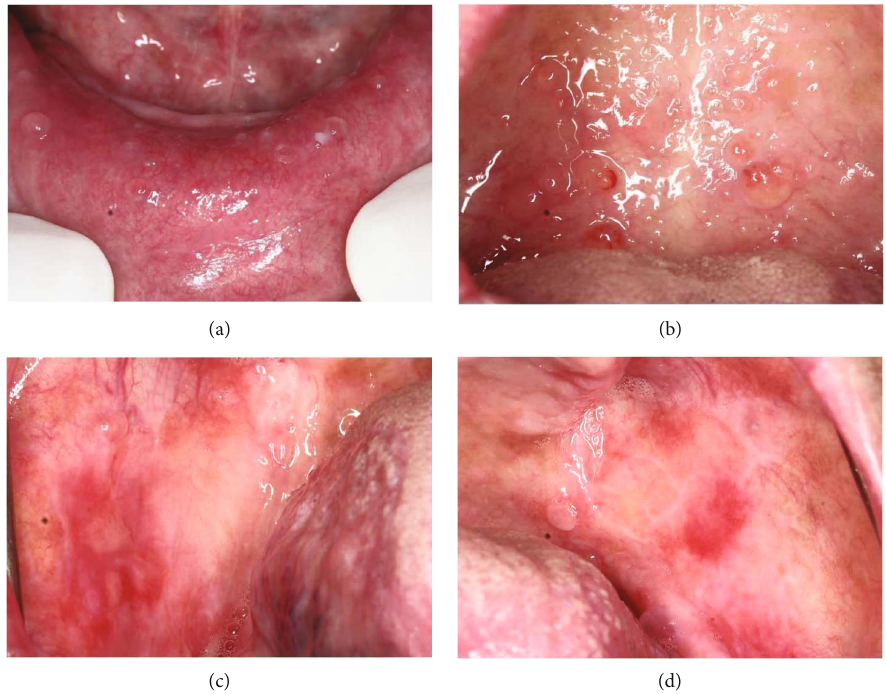
Figure 1: Multiple super fi cial mucoceles at the lower labial mucosa (a) and at the soft palate with no OLP lesion (b). White striation, erythema, and ulcerated areas at the bilateral buccal mucosa with super fi cial mucoceles in the adjacent area (c,